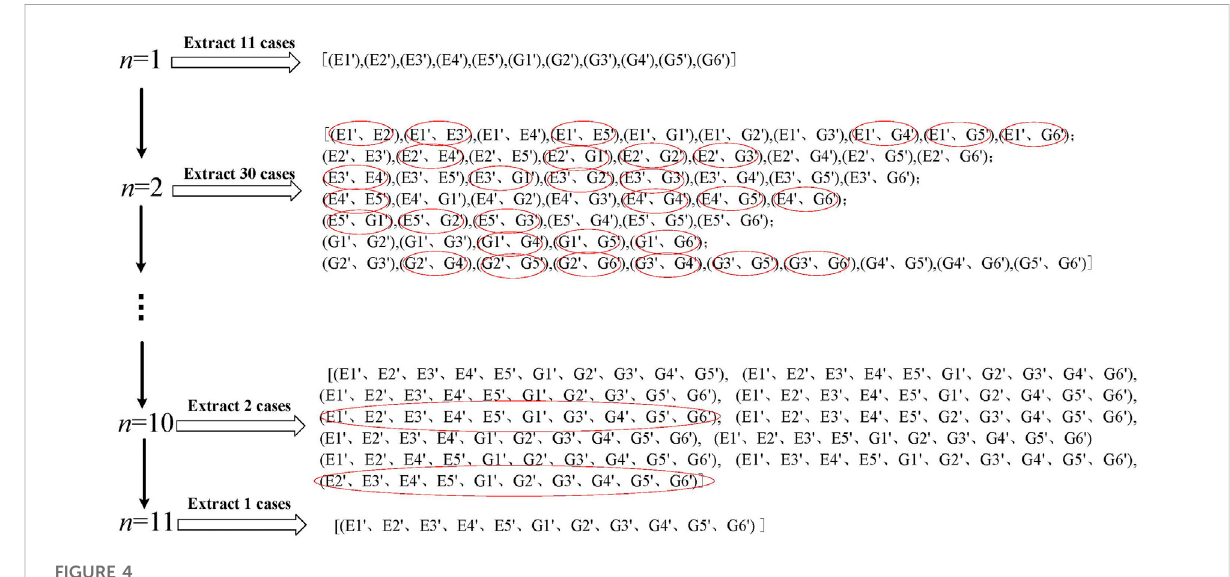
FIGURE 4 Schematic diagram of simulated sampling for cyber